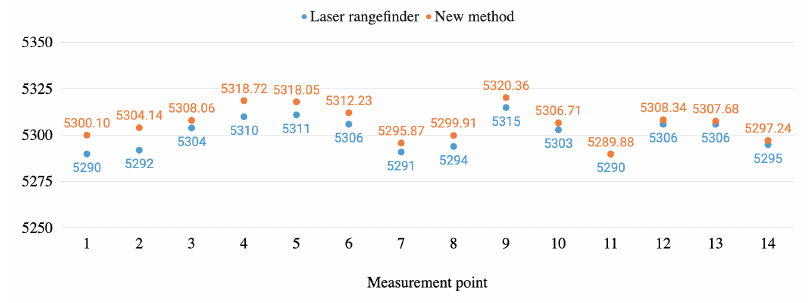
Figure 11. Height measurements’ comparison between the new method and the laser rangefinder in the real infrastructure